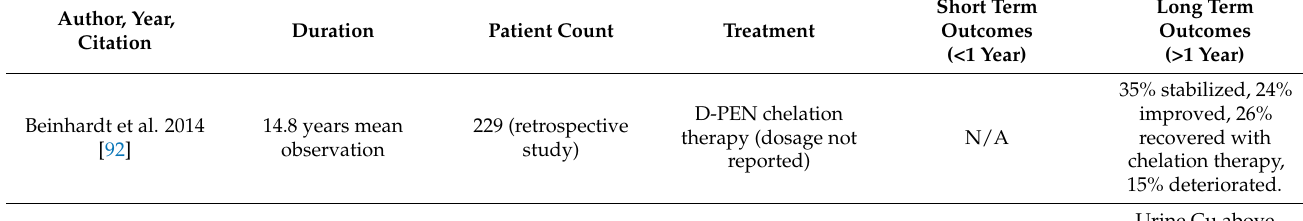
Table 1. Summary of Zn and chelator treatment studies in Wilson